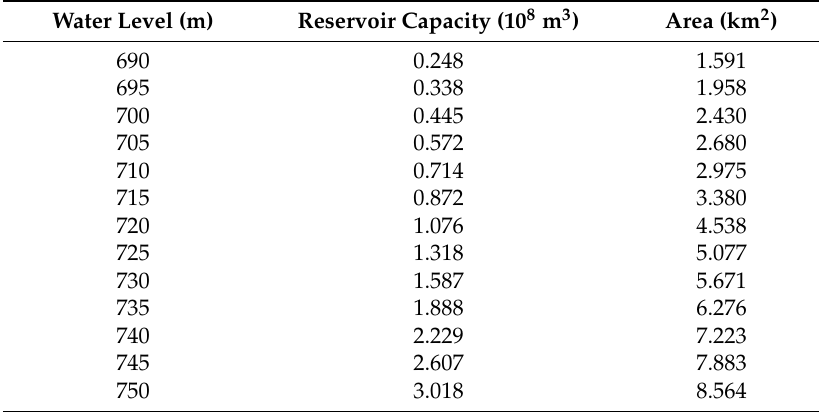
Table 2. Elevation-area-reservoir capacity